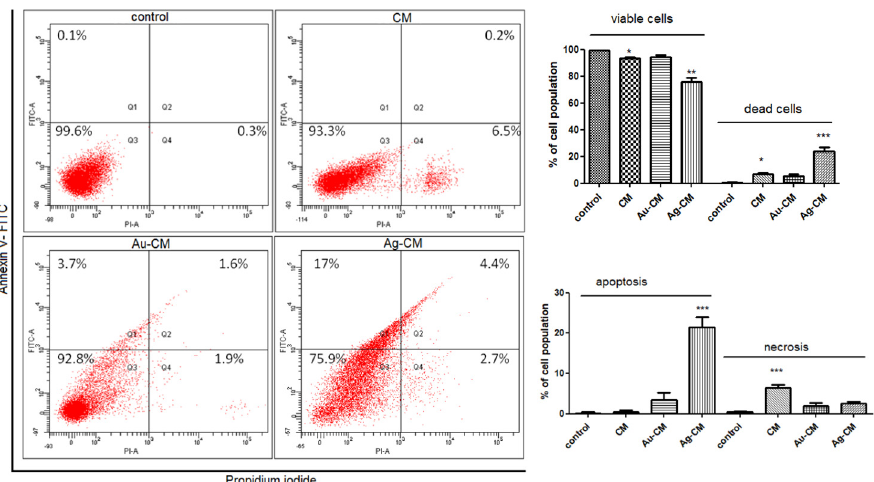
Figure 8. Flow cytometric analysis of DLD-1 cells treated with CM extract, Au-CM or Ag-CM. Staining was performed with annexin V/PI. CM extract decreased cell viability by necrosis, while Ag-CM significantly decreased cell viability mainly by apoptosis. Quantitative FACS results for DLD-1 are expressed as % of total cell number (left panel). The quadrants have the following meaning: viable cells (bottom left), early apoptosis (top left), late apoptosis (top right), necrosis (bottom right). Statistical analysis was performed with one-way ANOVA and Bonferroni’s posttest (* p < 0.05, ** p < 0.01, *** p < 0.001 treated cells vs. untreated control cells). Western blot analysis (Figure 9). p53 protein increased signi fi cantly after nanoparticle